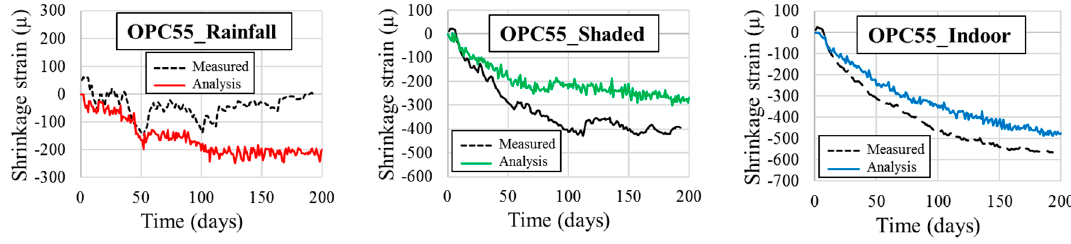
Figure 7. Concrete shrinkage strain of OPC55.